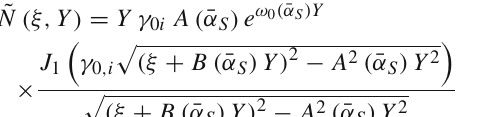
branch point when the radicand is equal to zero. Near the zero of the radicand ω (cid:4)(cid:4) ( ¯ α S , γ ) takes the